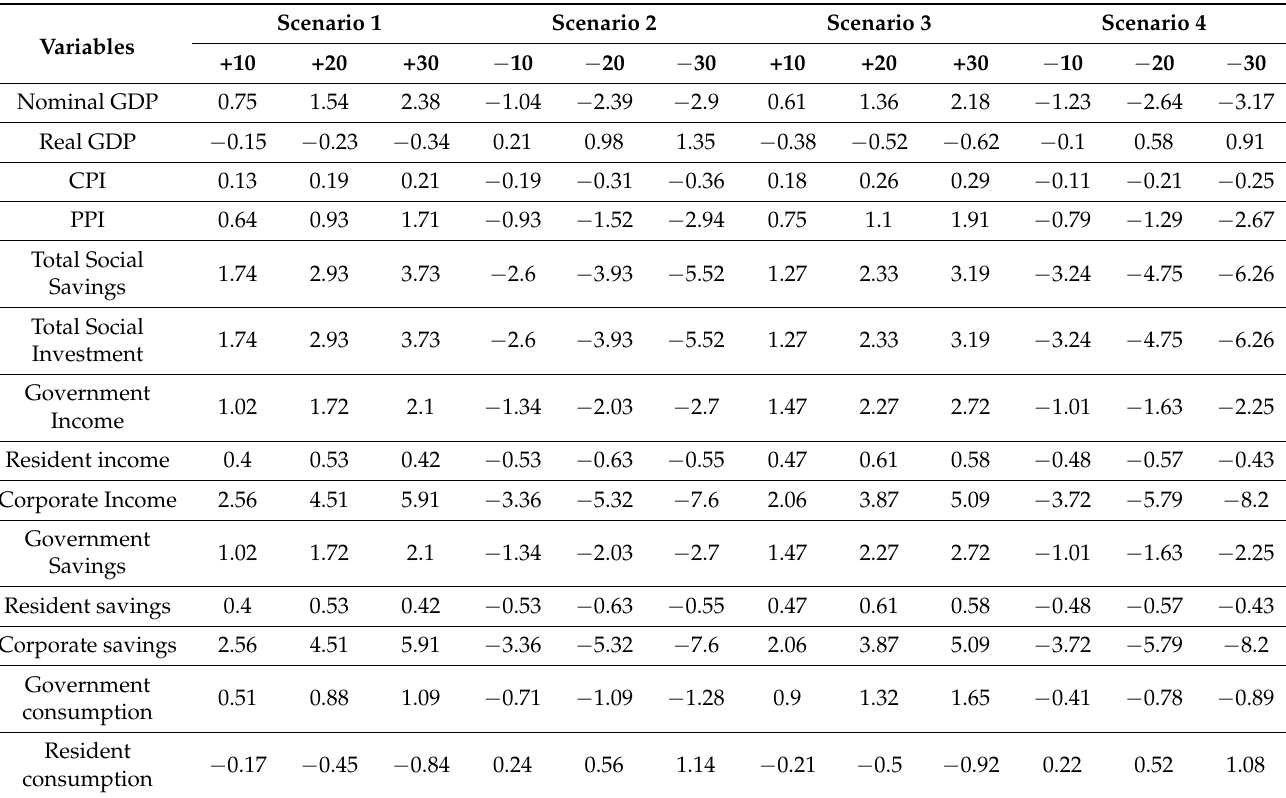
Table 2. Impact of scenario mix on macroeconomic variables Unit: